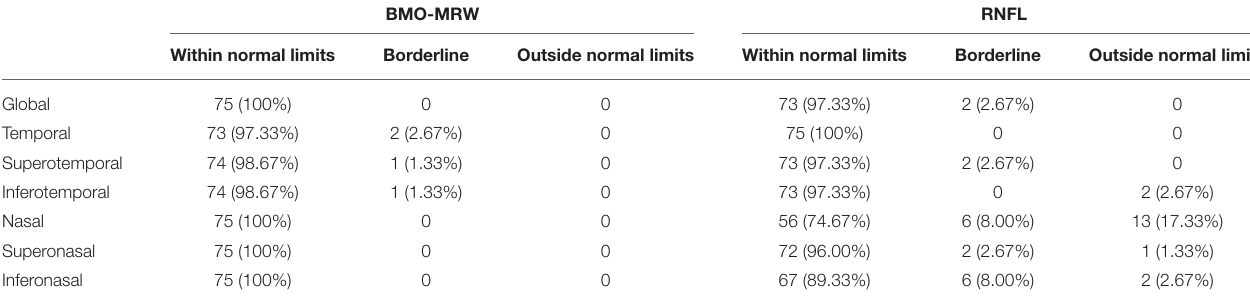
Within normal limits Outside normal limits Within normal limits Borderline Outside normal